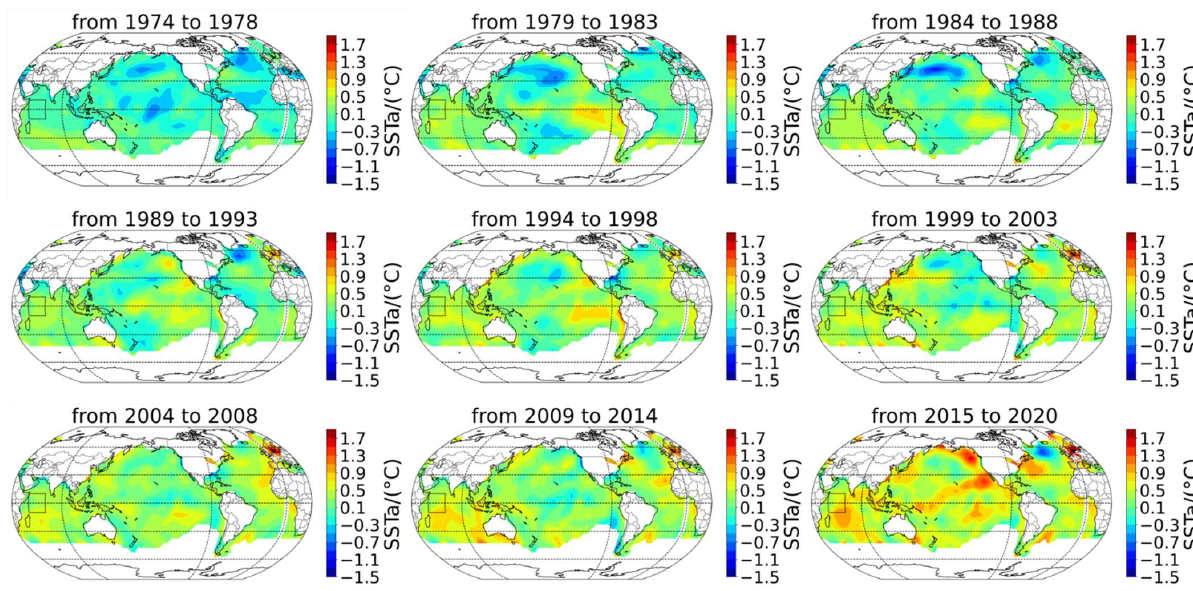
Figure 1. Distribution of global SST anomalies in the past 50 years. The area enclosed by the black box is the research area of the article.